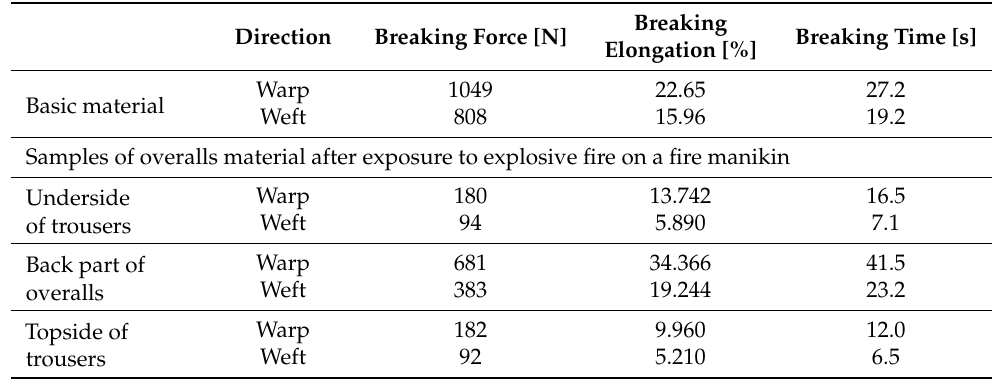
Table 1. Results of the tensile properties of basic materials (before heat exposure) and of the part samples of the overalls after exposure to explosive fire on a fire